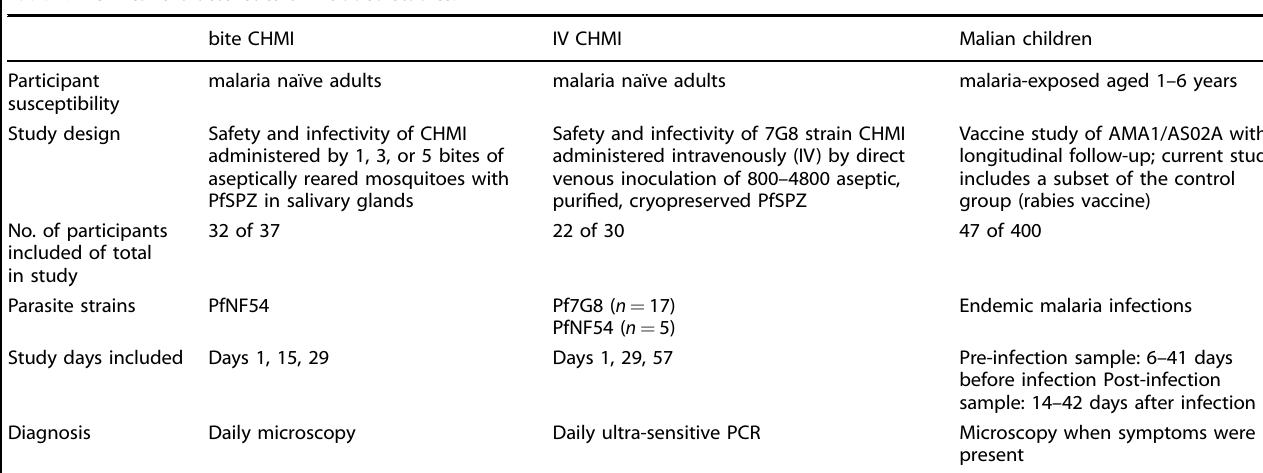
Table 1. Clinical characteristics of included